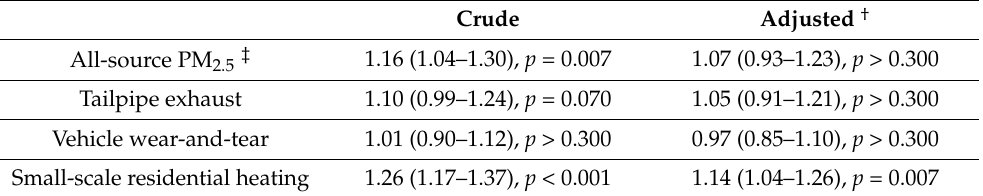
Table 3. Odds ratios and their (95% confidence intervals) of low birth weight (LBW; <2500 g) associated with an interquartile range (IQR) * increase in exposure concentrations of the investigated local PM 2.5 sources during